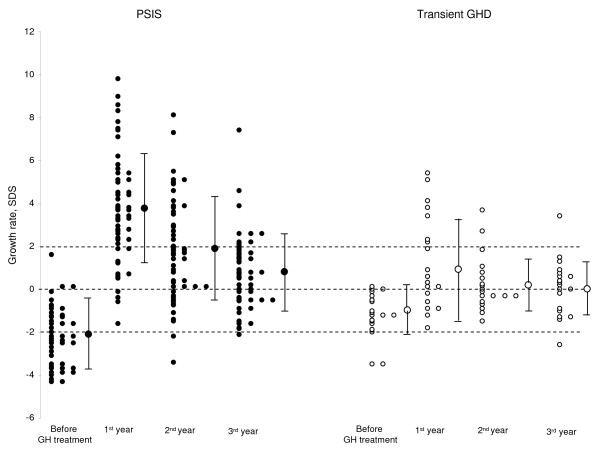
Growth rates before and during the first three years of GH treatment.